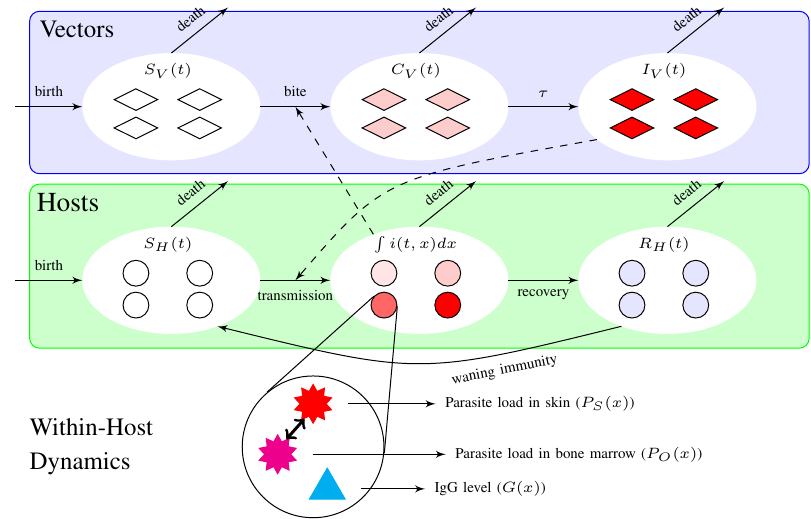
Fig. 1: The flow-chart of the immuno-epidemiological model of VL in dogs